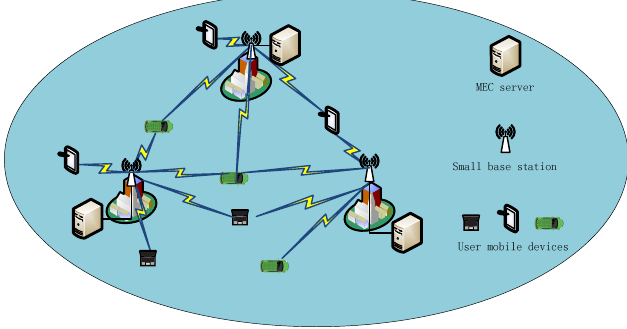
Figure 1. The system model under ultra ‐ dense network scenario.